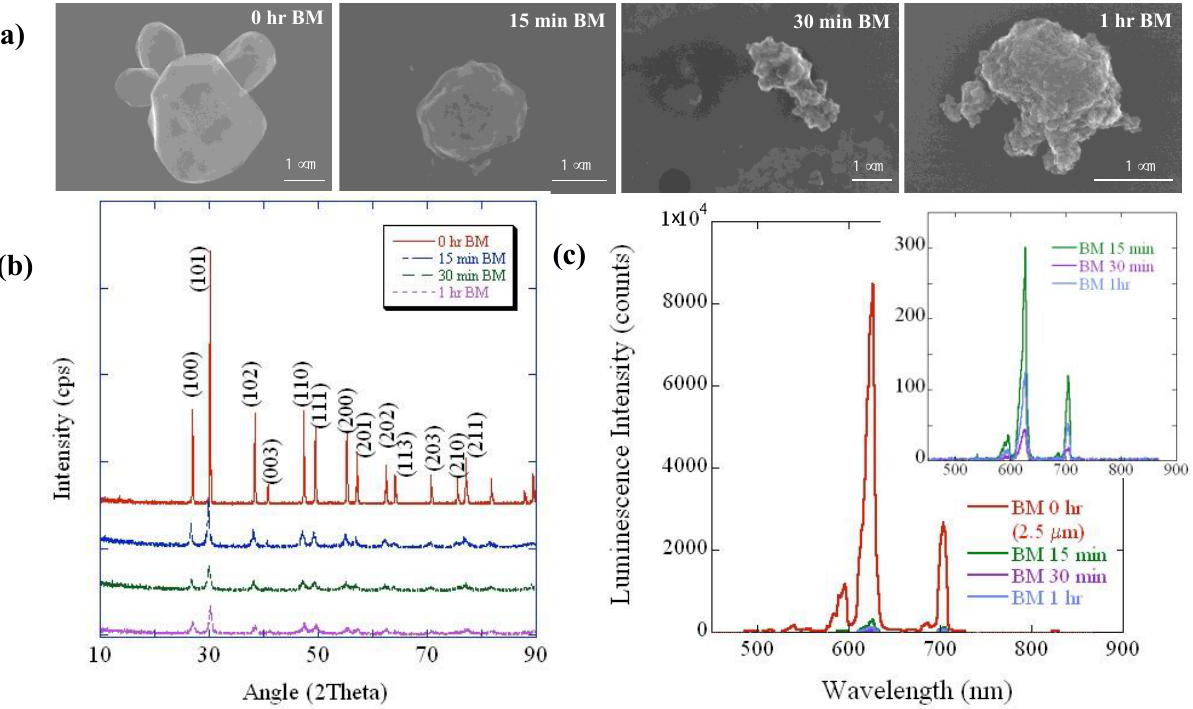
Figure 2. Short-term ball milling of commercial Gd 2 O 2 S:Eu 2.5 micron particles. Structural charac- terization of the commercial 2.5 µ m Gd 2 O 2 S: Eu microparticles before and after ball milling using ( a ) STEM and ( b ) X-ray diffraction. ( c ) Corresponding luminescence intensity of the commercial and ball-milled particles. Inset shows the magnified plot of luminescence intensity of the ball-milled particles only.